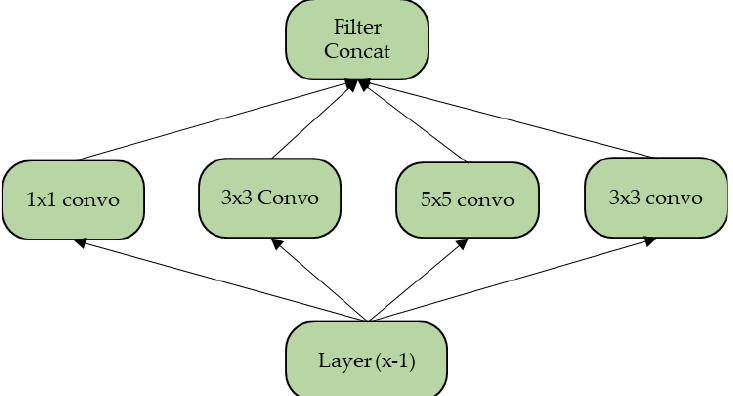
Figure 2. Classic Inception model with filters of different values.